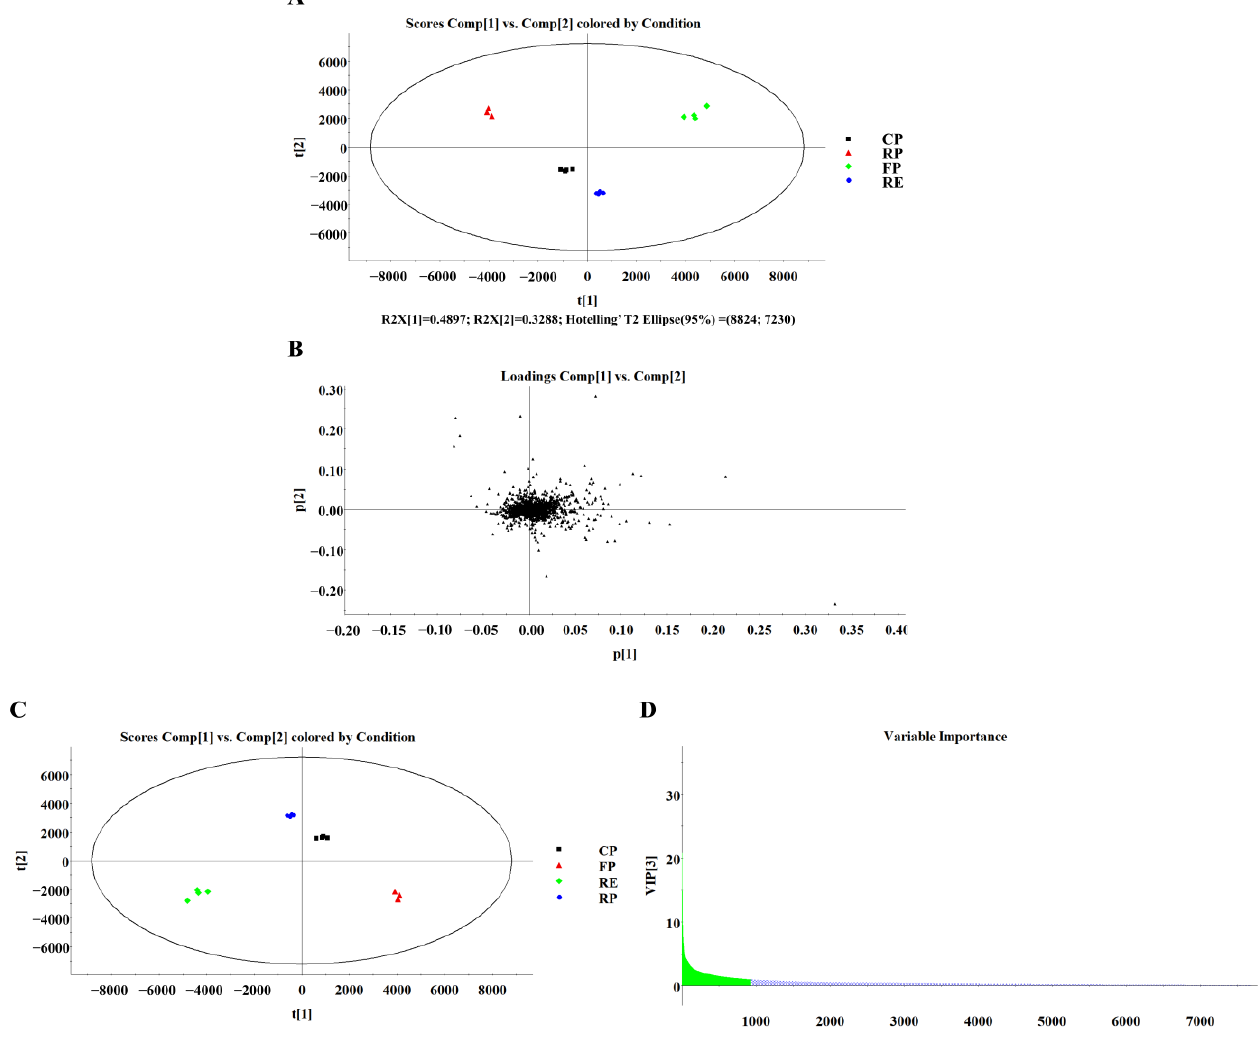
Figure 1. PCA score plot ( A ); PCA loading plot ( B ); PLS-DA scores plot ( C ); PLS-DA variable importance plot ( D ). CP, cold-pressed; RP, roast-pressed; HP, fresh-pressed; RE, refined.